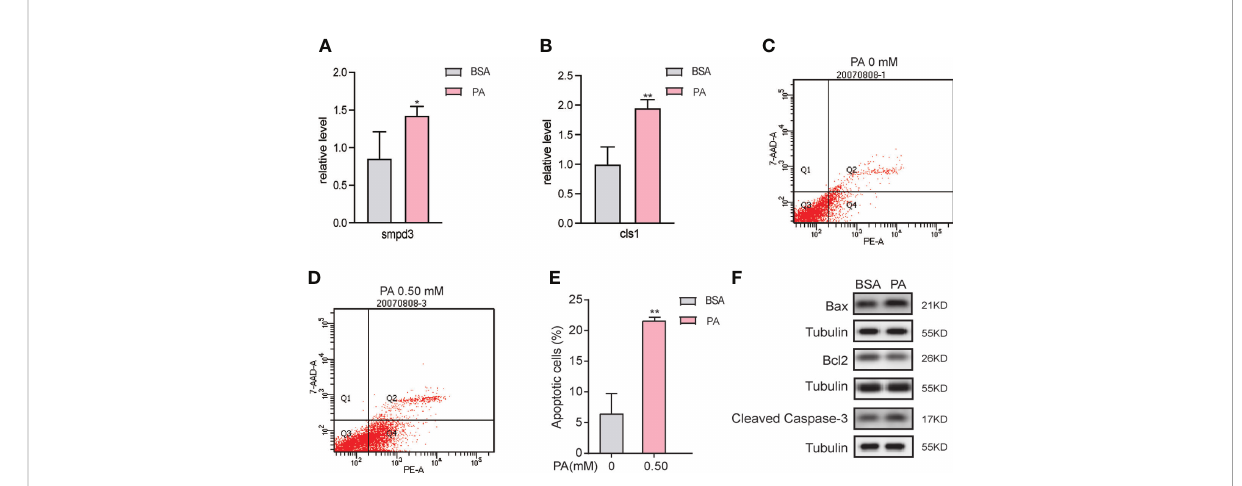
FIGURE 6 PA overload promotes apoptosis in SCs. (A, B) mRNA expression levels of smpd3 and cls1 in PA-treated SCs. (C – E) After PA treatment at concentrations of 0 mM and 0.5 mM for 24 h, the apoptosis rate of SCs was detected by fl ow cytometry (FCM). (F) Apoptosis-related protein expression in PA-treated SCs. 7-AAD, 7-aminoactinomyosin D. Data were expressed as mean ± SD, *p < 0.05, **p <